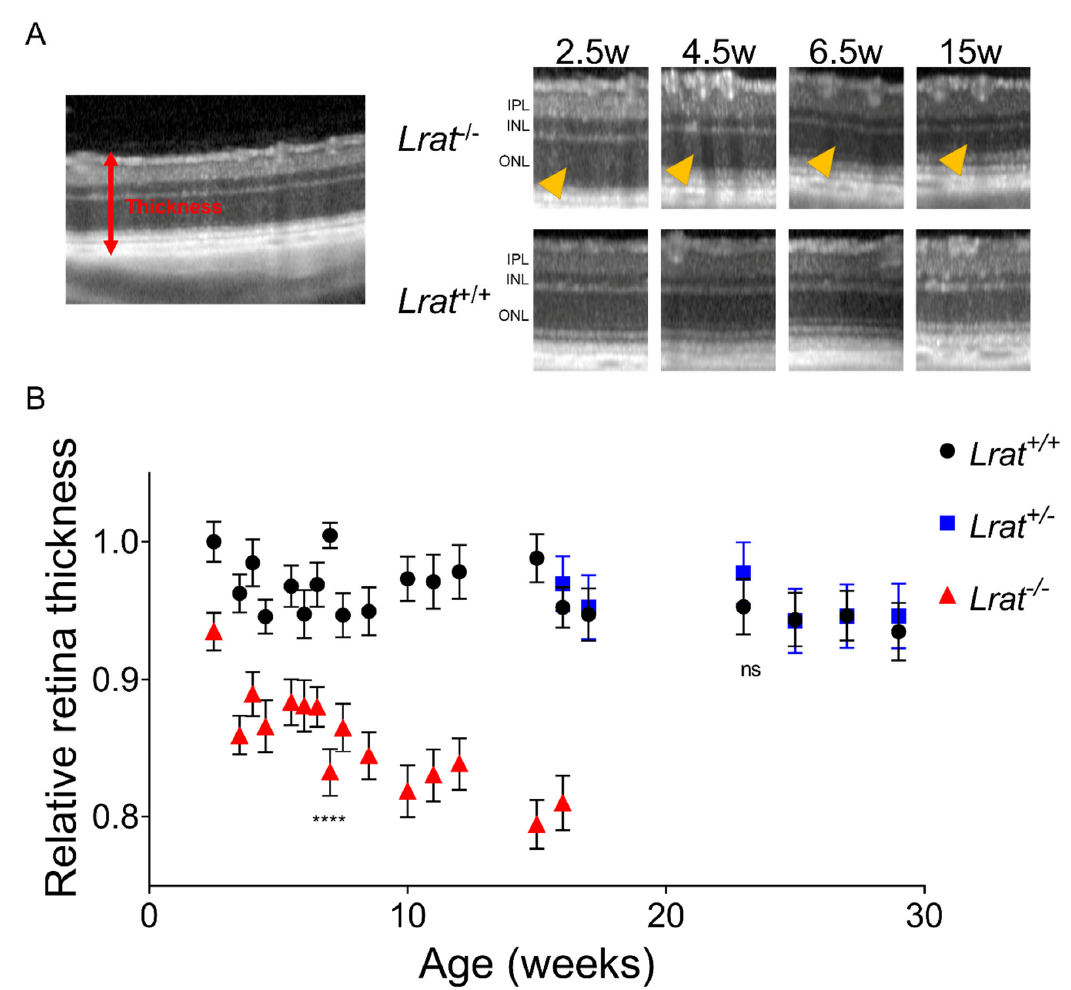
Figure 6. ( A ) quantitative representation of total retina thickness ( A ) at different ages of Lrat +/+ (black circles), Lrat +/ − (blue squares), and Lrat − / − (red triangles) animals. The left panel of A shows how the total thickness was determined. The chosen scans for determining total thickness were the crossing of the optic nerve (ON = 0), the middle superior section (ON + 10), the superior section (ON + 20), the middle inferior section (ON − 10), and the inferior section (ON − 20). Within each selected OCT scan, retina thickness was determined on 1 mm intervals, with a 0.5 mm minimum distance from the optic nerve. All values were normalized to the wildtype retina’s thickness at 2 weeks of age and plotted with the standard error (panel ( B )). Some variation between OCT measurements can be observed over time, although not significant within the wildtype and heterozygote animals. The retina of knockout animals degenerates over time and is significantly thinner than the retina of wildtype and heterozygous animals. The thinning is mostly due to the degeneration of the outer nuclear layer (ONL) (yellow arrows) (A). No significant differences are observed between wildtype and heterozygous animals. ns = non ‐ significant; **** = p < 0.0001. IPL: inner plexiform layer; INL: inner nuclear layer.